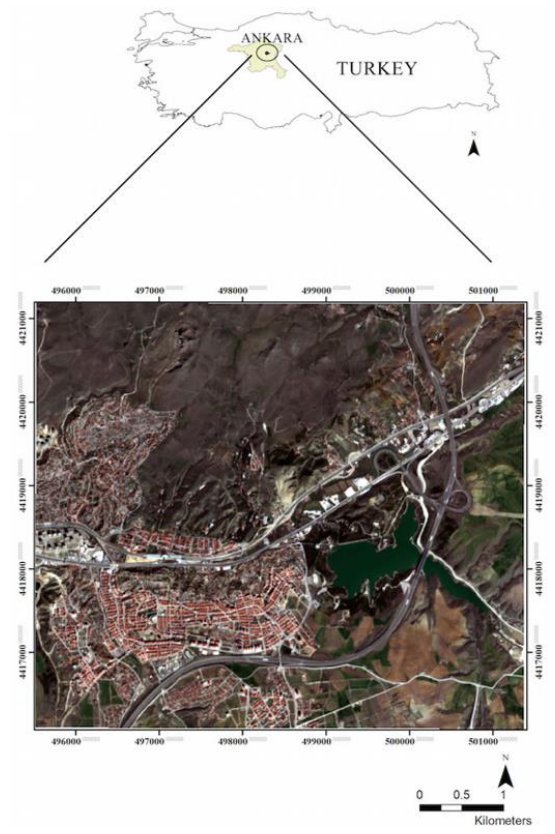
Figure 1. The location of the study area and an overview of the Sentinel-2 RGB image used in the study